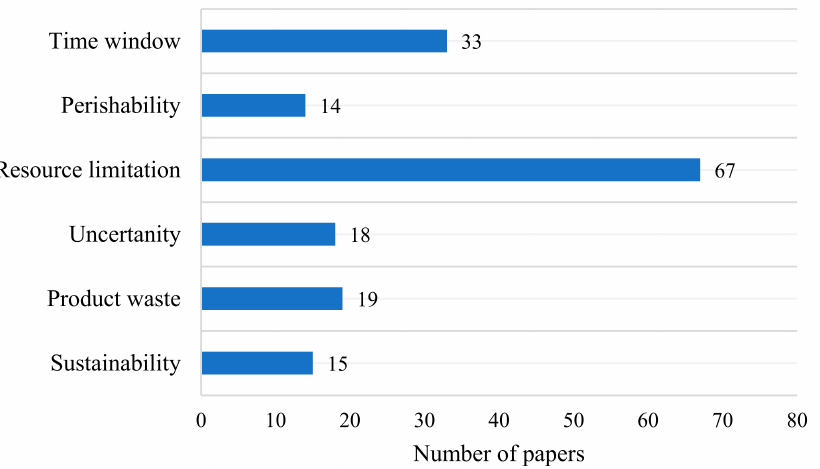
Figure 4. Number of papers regarding problem